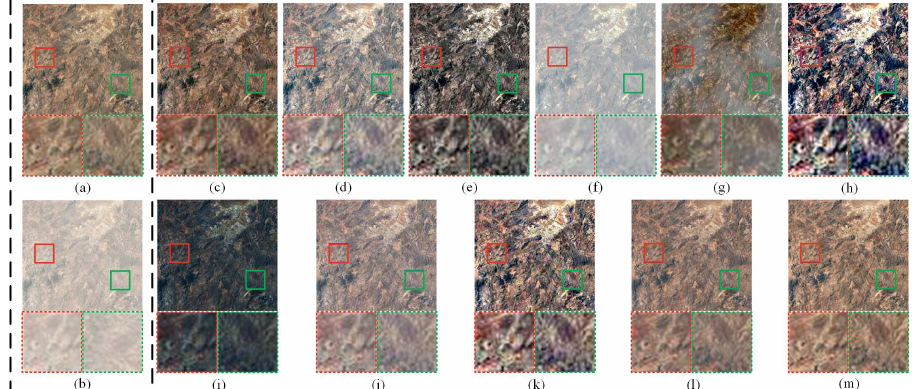
Figure 11. An image dehazing example of a remote sensing non-urban image from a synthetic hazy scene: ( a ) A haze-free image; ( b ) a synthetic hazy image; ( c ) DCP; ( d ) GPR; ( e ) AMP; ( f ) DEFADE; ( g ) WCD; ( h ) RRO; ( i ) MOF; ( j ) CAP; ( k ) HLM; ( l ) DN; ( m ) Proposed. Two partially enlarged images marked in red and green dotted frames correspond to the regions surrounded by red and green frames in the dehazed